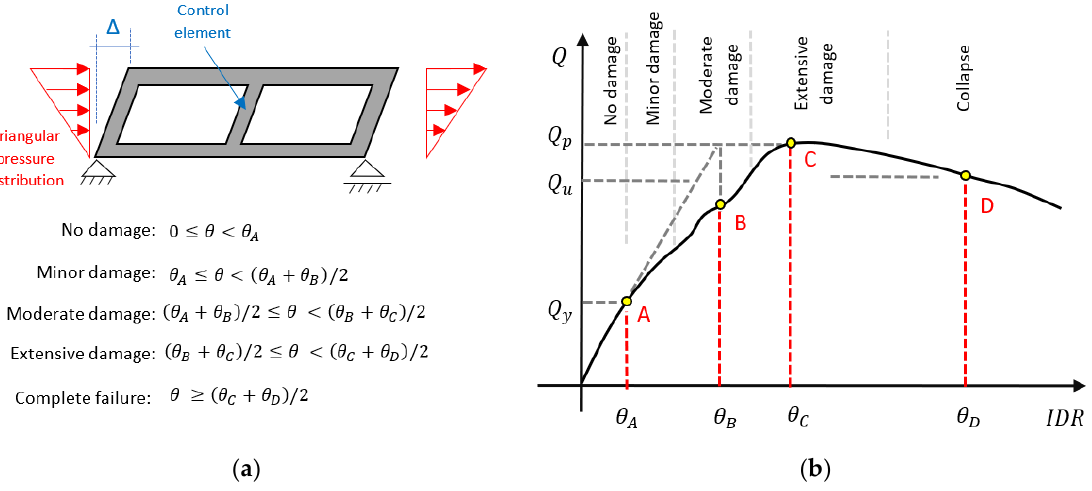
Figure 9. ( a ) Conceptual model for pushover analysis of an embedded structure/station and defini- tion of control element for recording capacity, ( b ) definition of thresholds of damage/performance states on shear force–drift capacity curve developed via the pushover analysis ( θ A : drift ratio corresponding to yield point A, θ C : drift ratio corresponding to peak strength point C, θ B : drift ratio corresponding to point B, defined by the intersection point between the extension line of the initial stiffness and the horizontal line corresponding to the peak shear force, θ D : drift ratio corresponding to ultimate strength point D, defined at the moment when shear force drops to 85% of the peak shear force) (modified after Zhong et al. [85]).